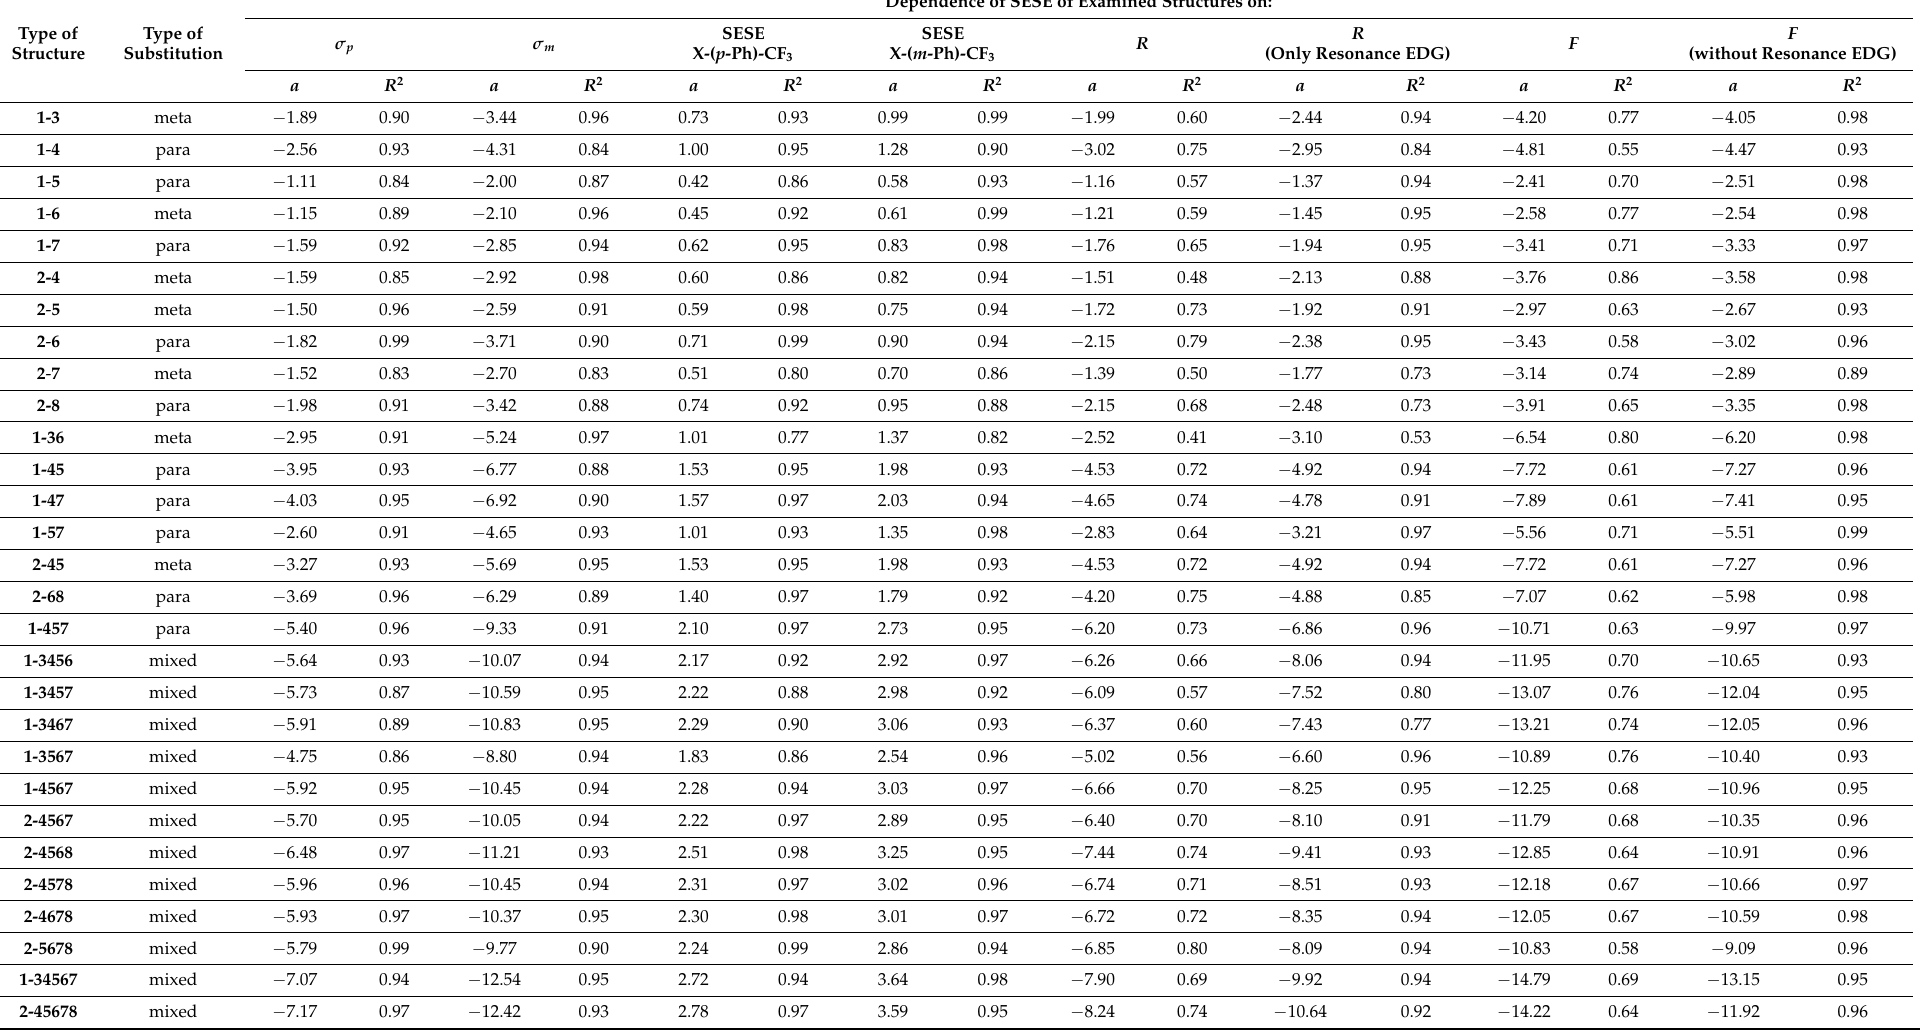
Table 2. Dependence of SESE values on different constants for the examined